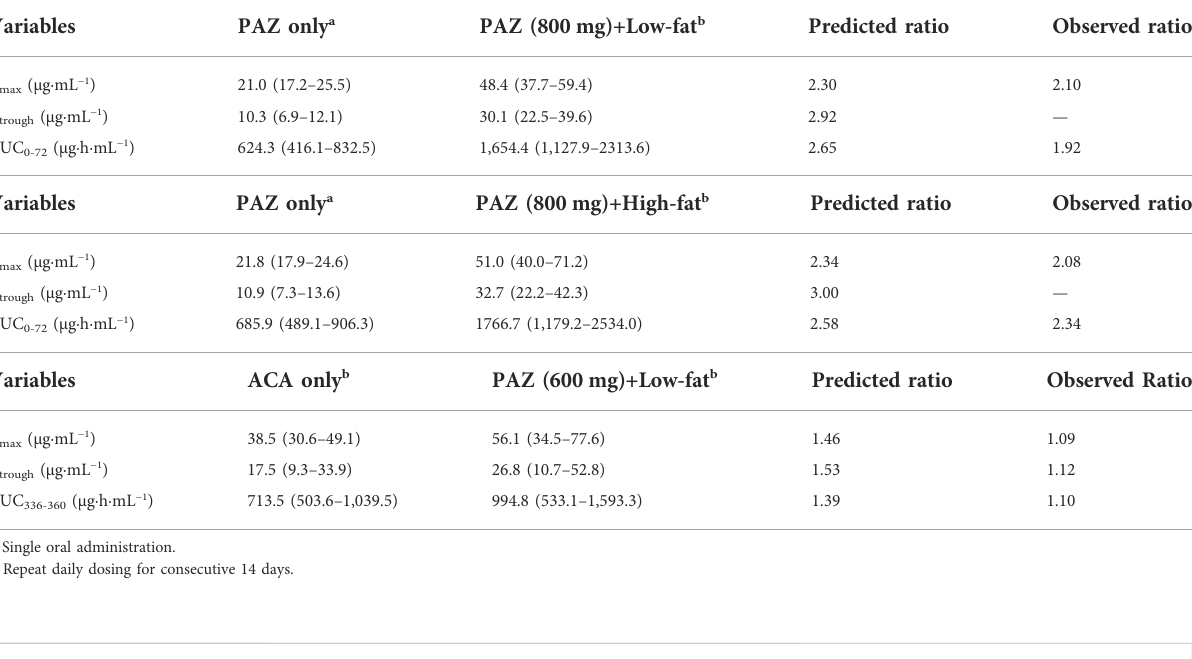
TABLE 6 PK variable (geometric mean, range) changes of PAZ with or without food.